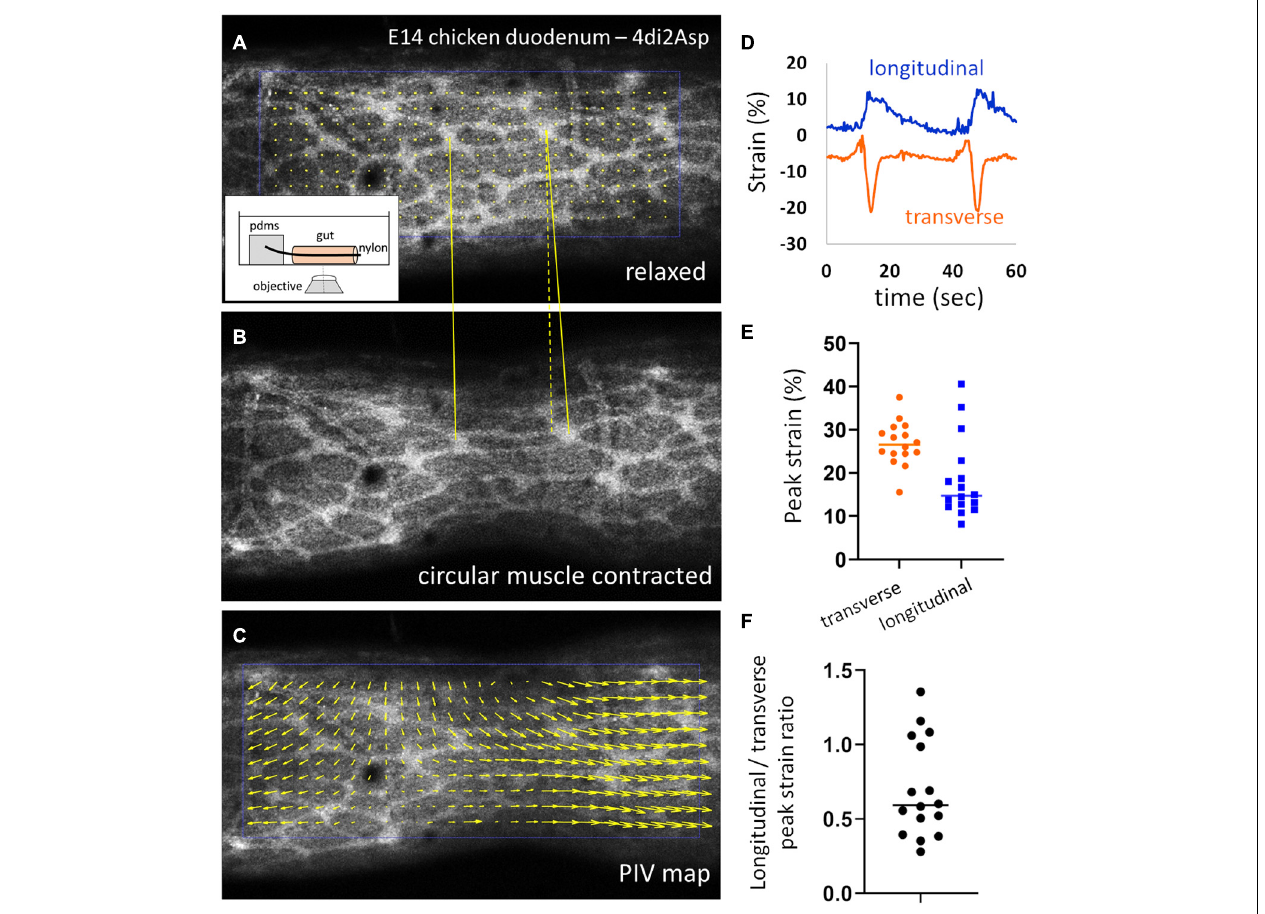
FIGURE 2 | Circular smooth muscle contractions induce a longitudinal strain component. (A,B) Frames from Supplementary Video 1 in the relaxed state and during a CSM contraction. Inset: experimental setup. (C) PIV map of displacement vectors retrieved from images (A) and (B) . (D) Representative longitudinal and transverse strain measured by ganglion tracking during two contraction events, the transverse strain is negative (compression) and the longitudinal strain positive (elongation). (E) Absolute values of peak transverse and longitudinal strain and (F) absolute peak longitudinal over peak transverse strain ratio measured for 16 contractions from n = 6 E14